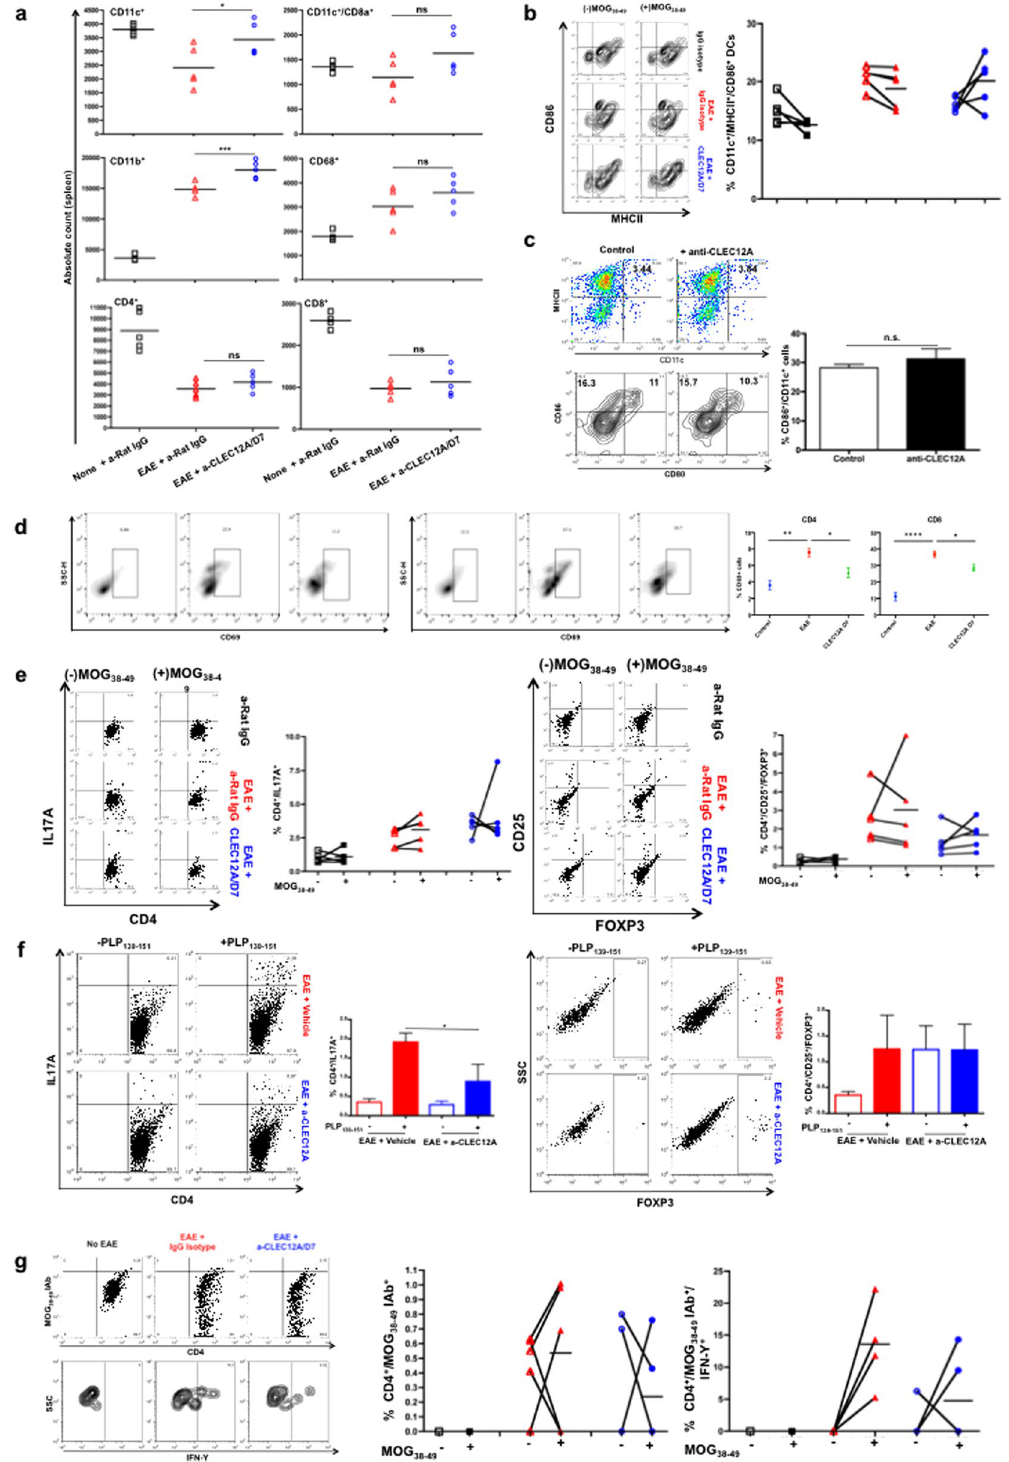
Figure 7. Quantification and functional analysis of myeloid cells within the spleen upon CLEC12A antibody treatment of both progressive and relapse-remitting EAE mice. ( a ) Splenocytes from C57BL/6 mice with control IgG isotype, EAE + IgG isotype and EAE + CLEC12A antibody treatment (Day 7) were stained for indicated immune cell markers for quantification. Each point represents absolute count of each individual marker for each animal in every group analyzed (n = 5) with a bar that represents mean count for each marker. ( b ) CD11c + cells expressing both MHCII and CD86 from splenocytes with and without MOG 35–55 stimulation for 3 days followed by activation with cell activation cocktail A for 5 h. Each point represents percentage of each individual marker for every group analyzed (n = 5) with a bar that represents mean percentage for each marker (right). Flow cytometric contour plots (left) showing one representation of MHCII + /CD86 + co-expression for all groups